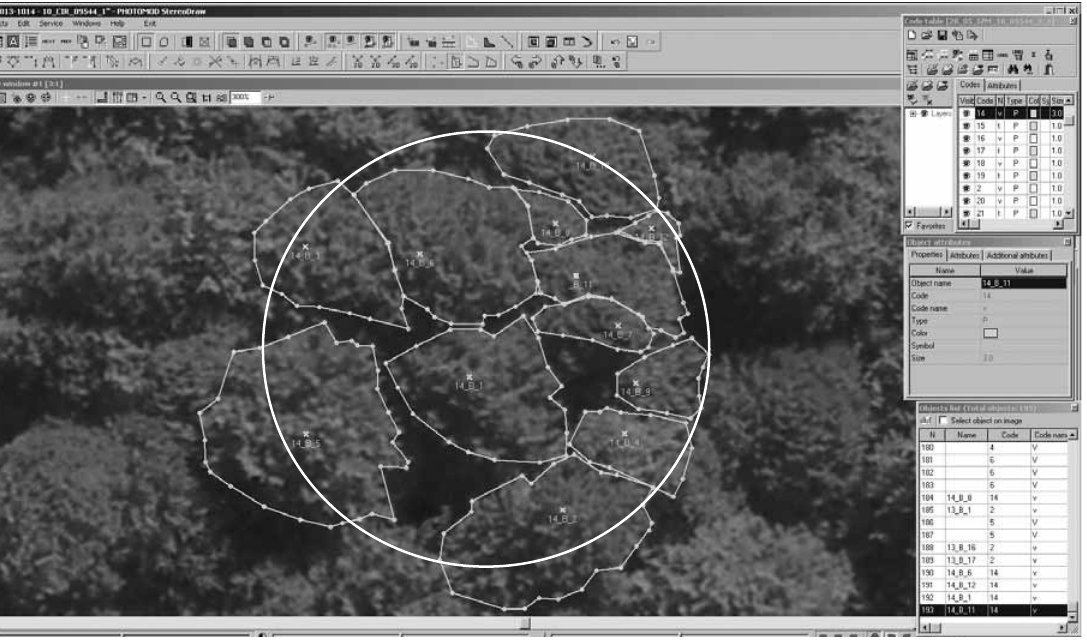
An example of a photogrammetric measurement of stand structure elements shown in model of CIR digital aerial images of GSD 10 cm in 2D window of StereoDraw module at magnification of 300 Determination of tree species and crown top, as well as crown delineation were performed for each tree on the plot (Figure 7).